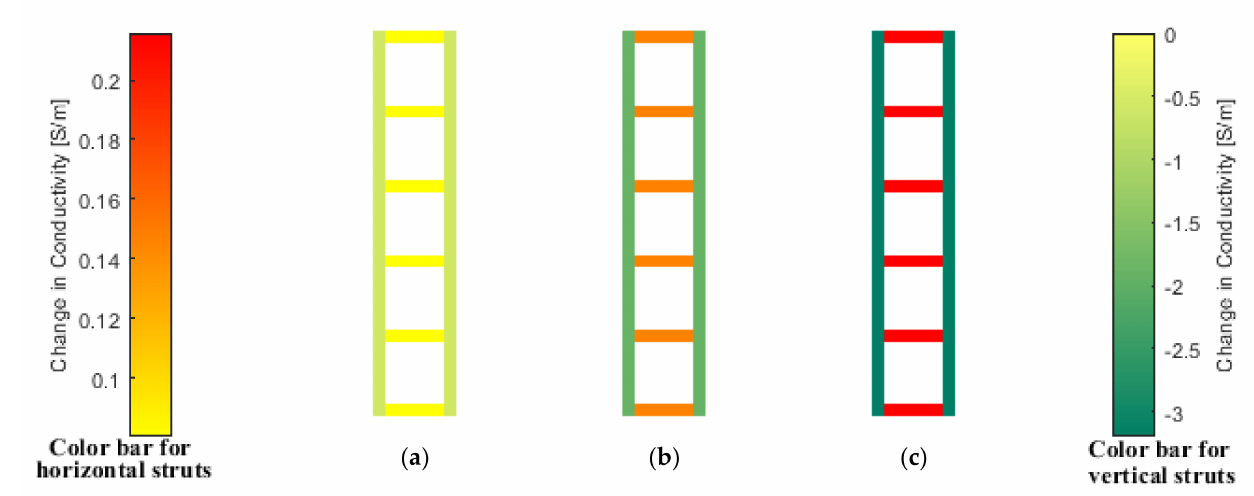
Figure 8. The reconstructed ERT conductivity maps when the sensing mesh was subjected to uniaxial tensile loads when the vertical displacement of the load frame grips was ( a ) 0.2, ( b ) 0.4, and ( c ) 0.6 mm are shown. Two color bars are used to visualize conductivity changes the for horizontal ( left color bar) and vertical ( right color bar) struts.